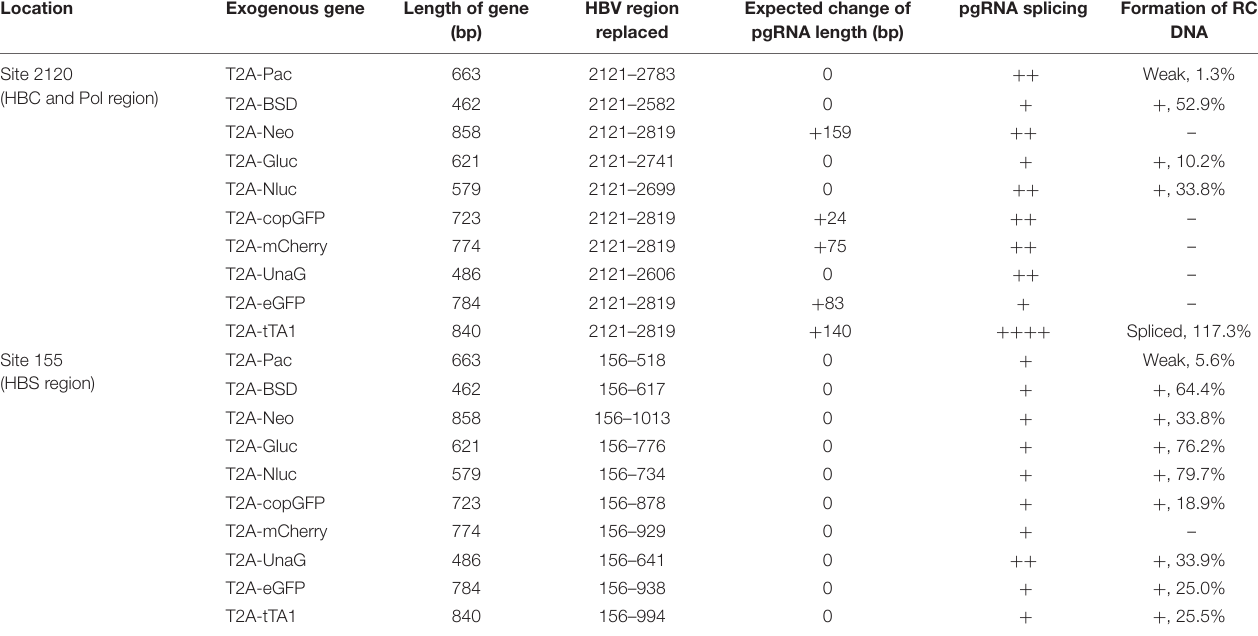
TABLE 2 | Influence of exogenous gene engineering on the formation of RC